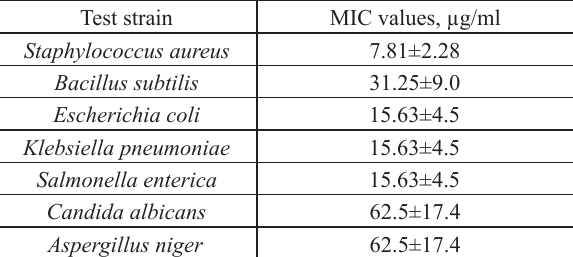
Results of antimicrobial activity testing